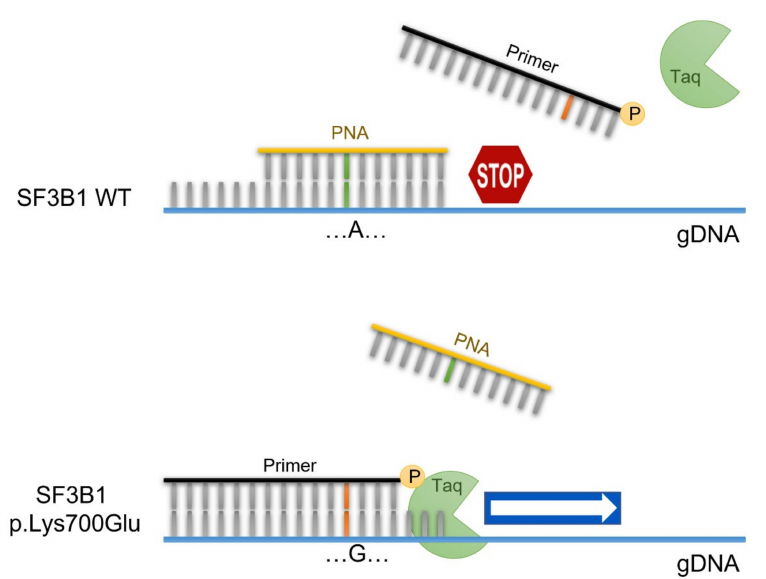
Figure 1. PNA-PCR clamping experimental design. Amplification of SF3B1 is performed in presence of the PNA probe ( yellow ), designed on the WT sequence, and the primer competitor ( black ), designed on the mutated sequence. In these conditions, the PCR of the WT sequence is inhibited by the hybridization of PNA/DNA. In contrast, in the presence of the SF3B1 p.Lys700Glu genotype, the primer/DNA duplex allows the amplification of the target